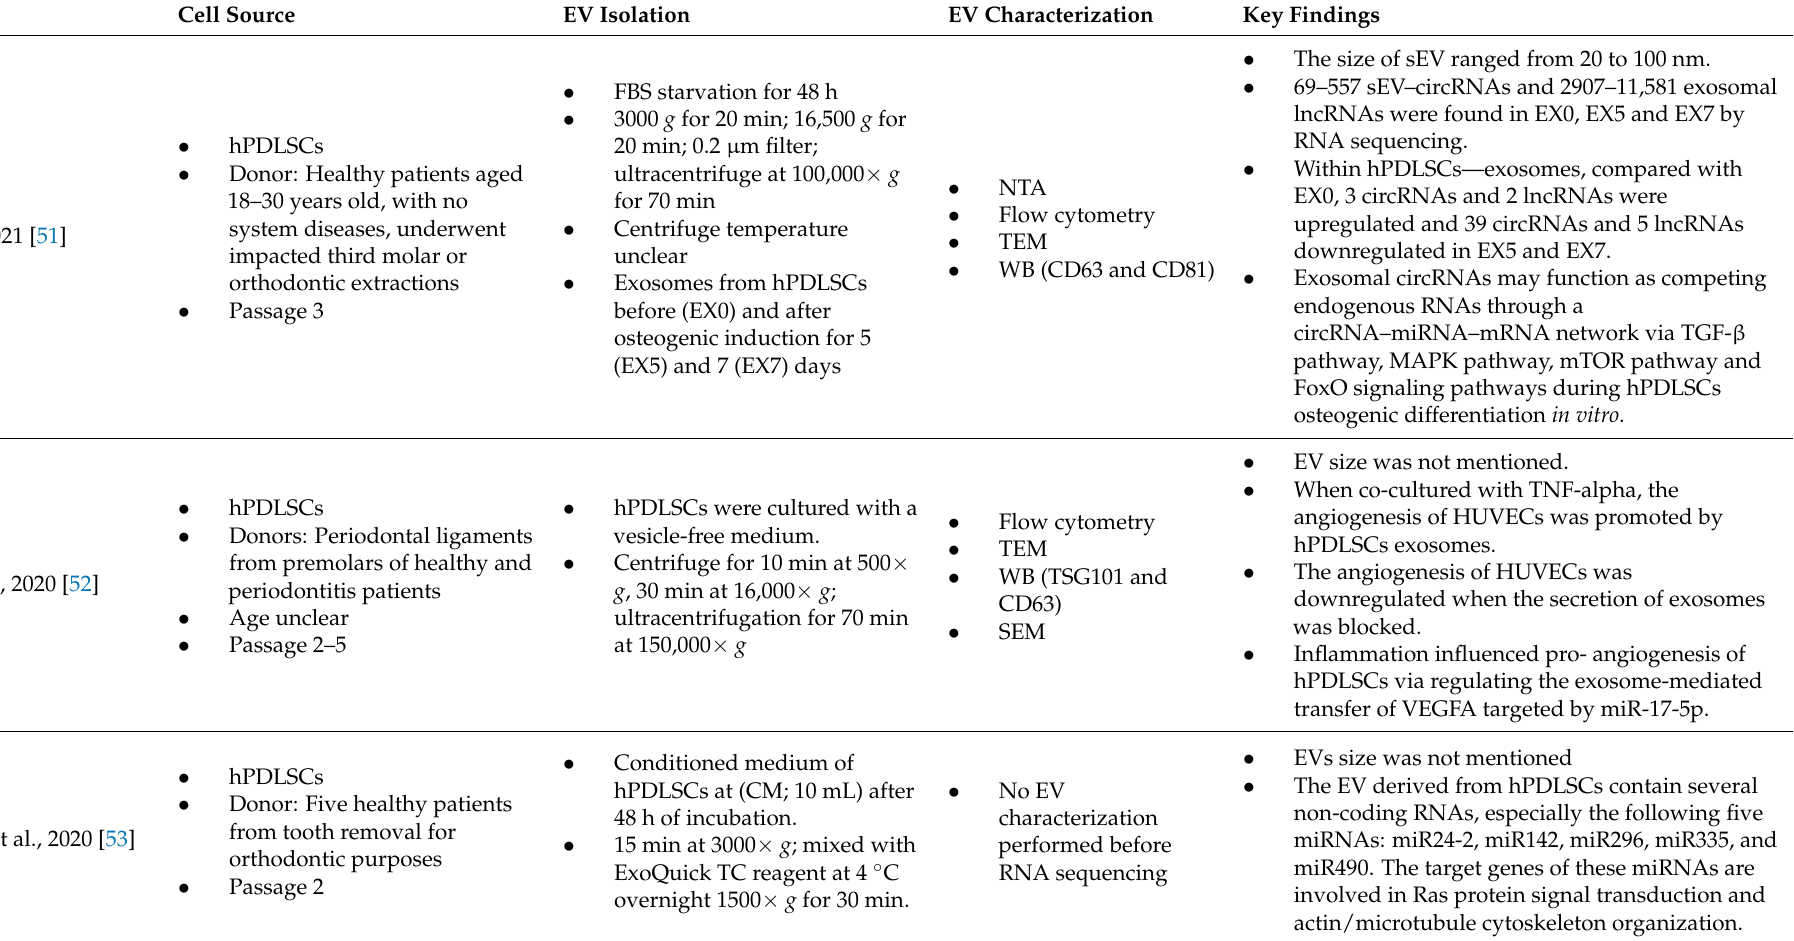
Table 2. The isolation, characterization, and function of PDL(S)C-derived